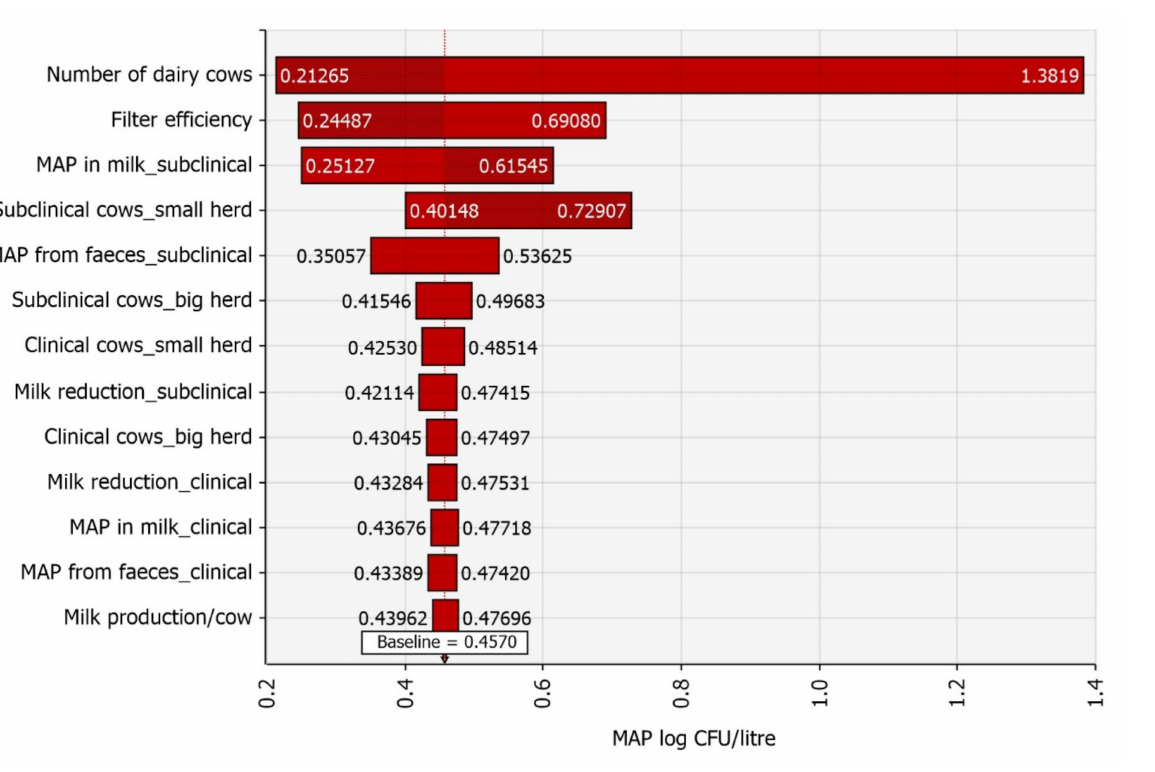
Figure 5. Input variables ranked by the effect on the mean raw bulk tank milk contamination with Mycobacterium avium subsp. paratuberculosis